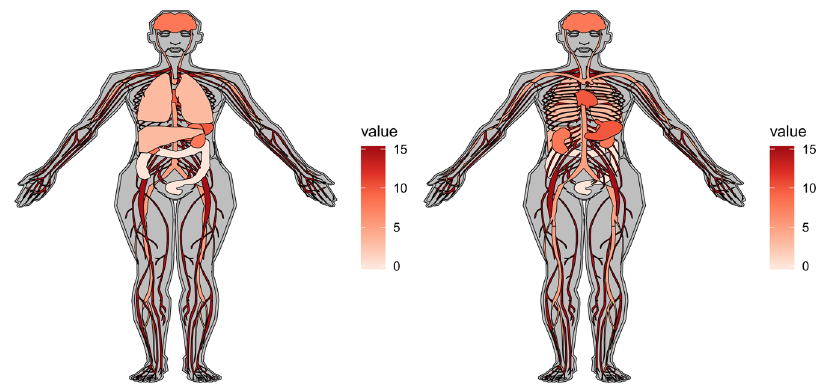
Figure 4. Changing the order of the data frame results in change in the layer of organs to plot.